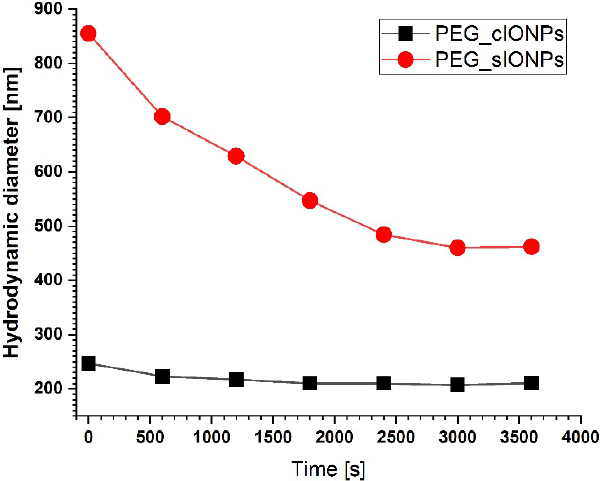
Figure 16. Aggregation behaviour of the PEG-coated IONPs. Notation in the figure: PEG_cIONPs— PEG-coated cubic IONPS, PEG_sIONPs—PEG-coated spherically shaped IONPs.